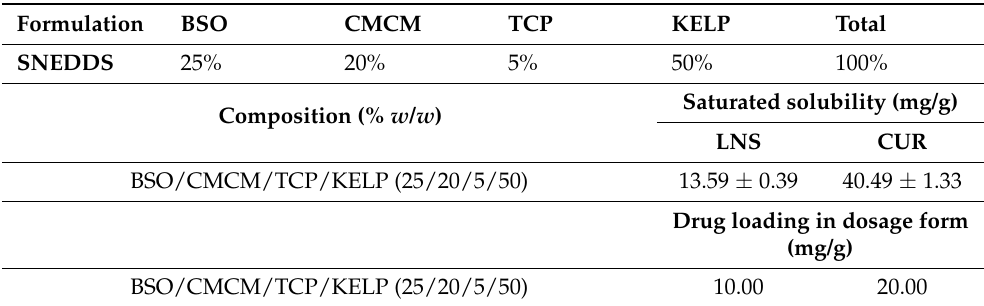
Table 1. Composition of SNEDDSs and their drug-loading capacity (saturated solubility).